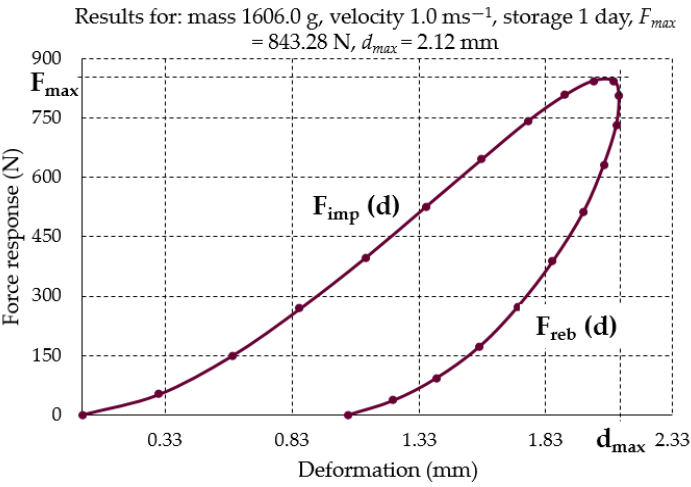
Figure 7. Typical relationship between the force response and the deformation during the impact and the rebound of sugar beet root.